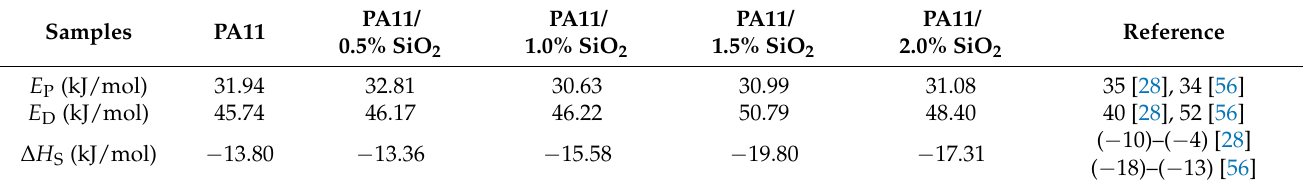
Table 3. Apparent activation energies for permeability, diffusion, and heat of solution of CO 2 in PA11. Samples